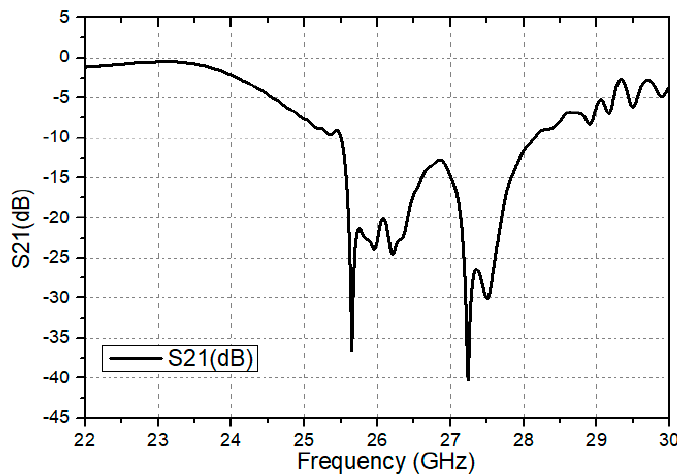
Figure 7. Simulated ( S 21 ) bandgap response EBG using a suspended line method.